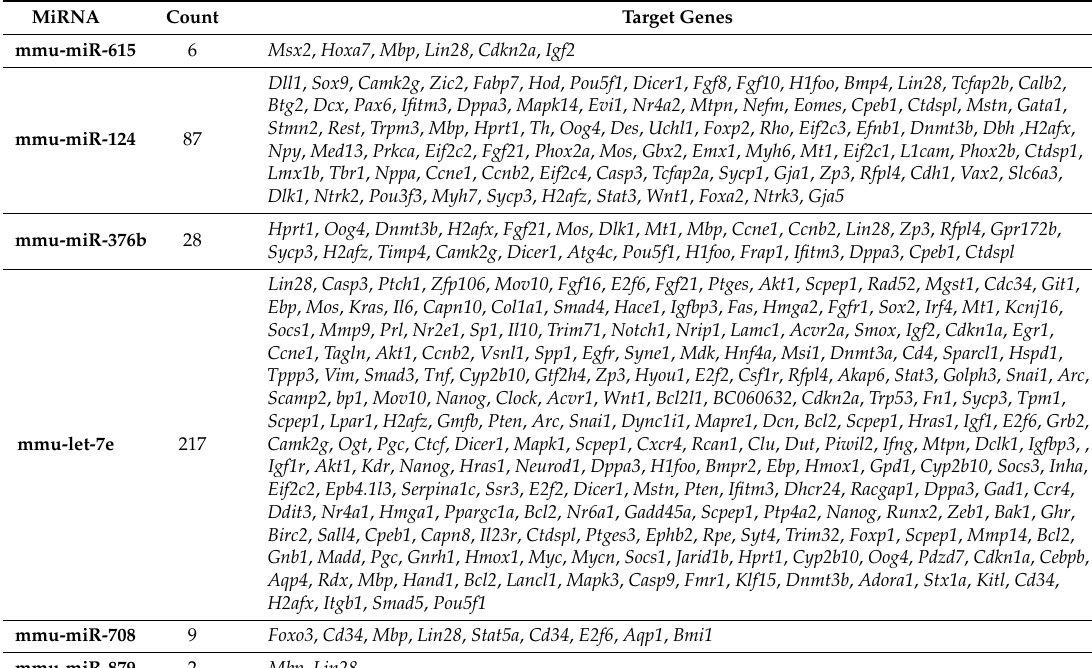
Table 2. Validated targeted genes for differentially ‐ expressed miRNAs.